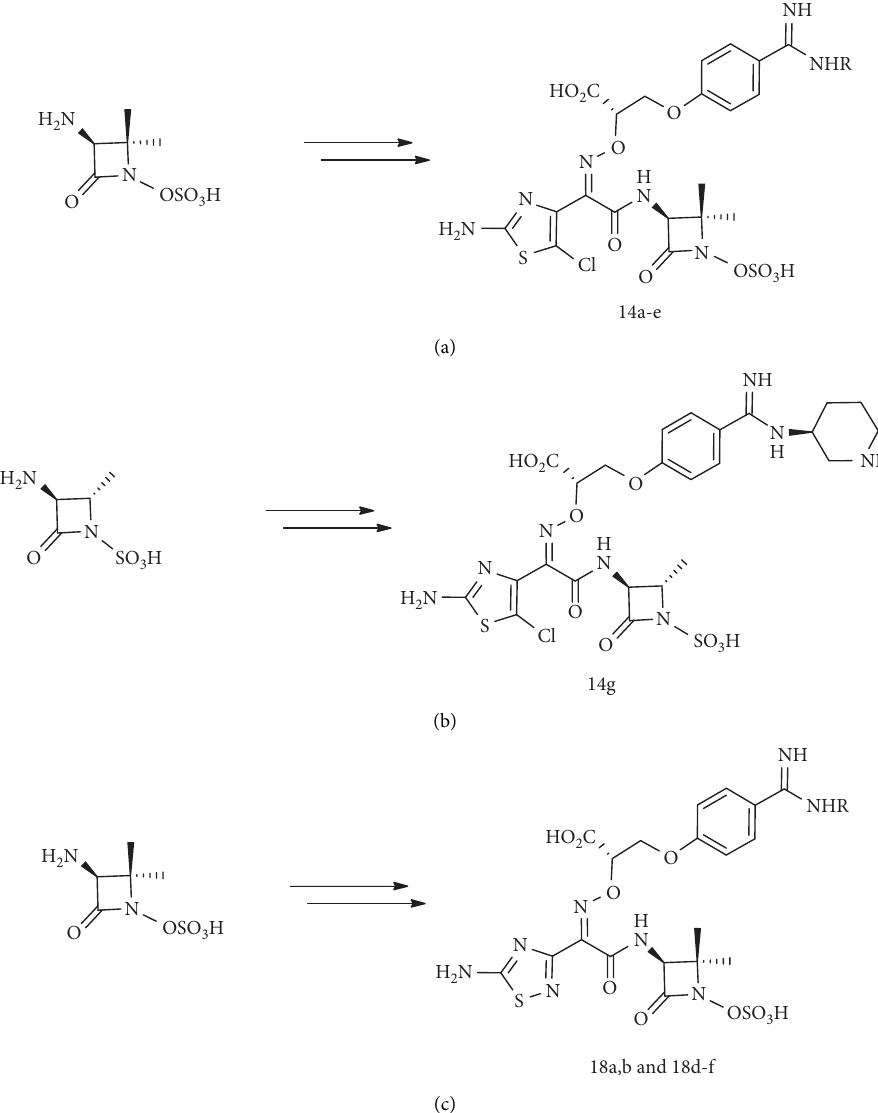
Figure 2: General structures of the target